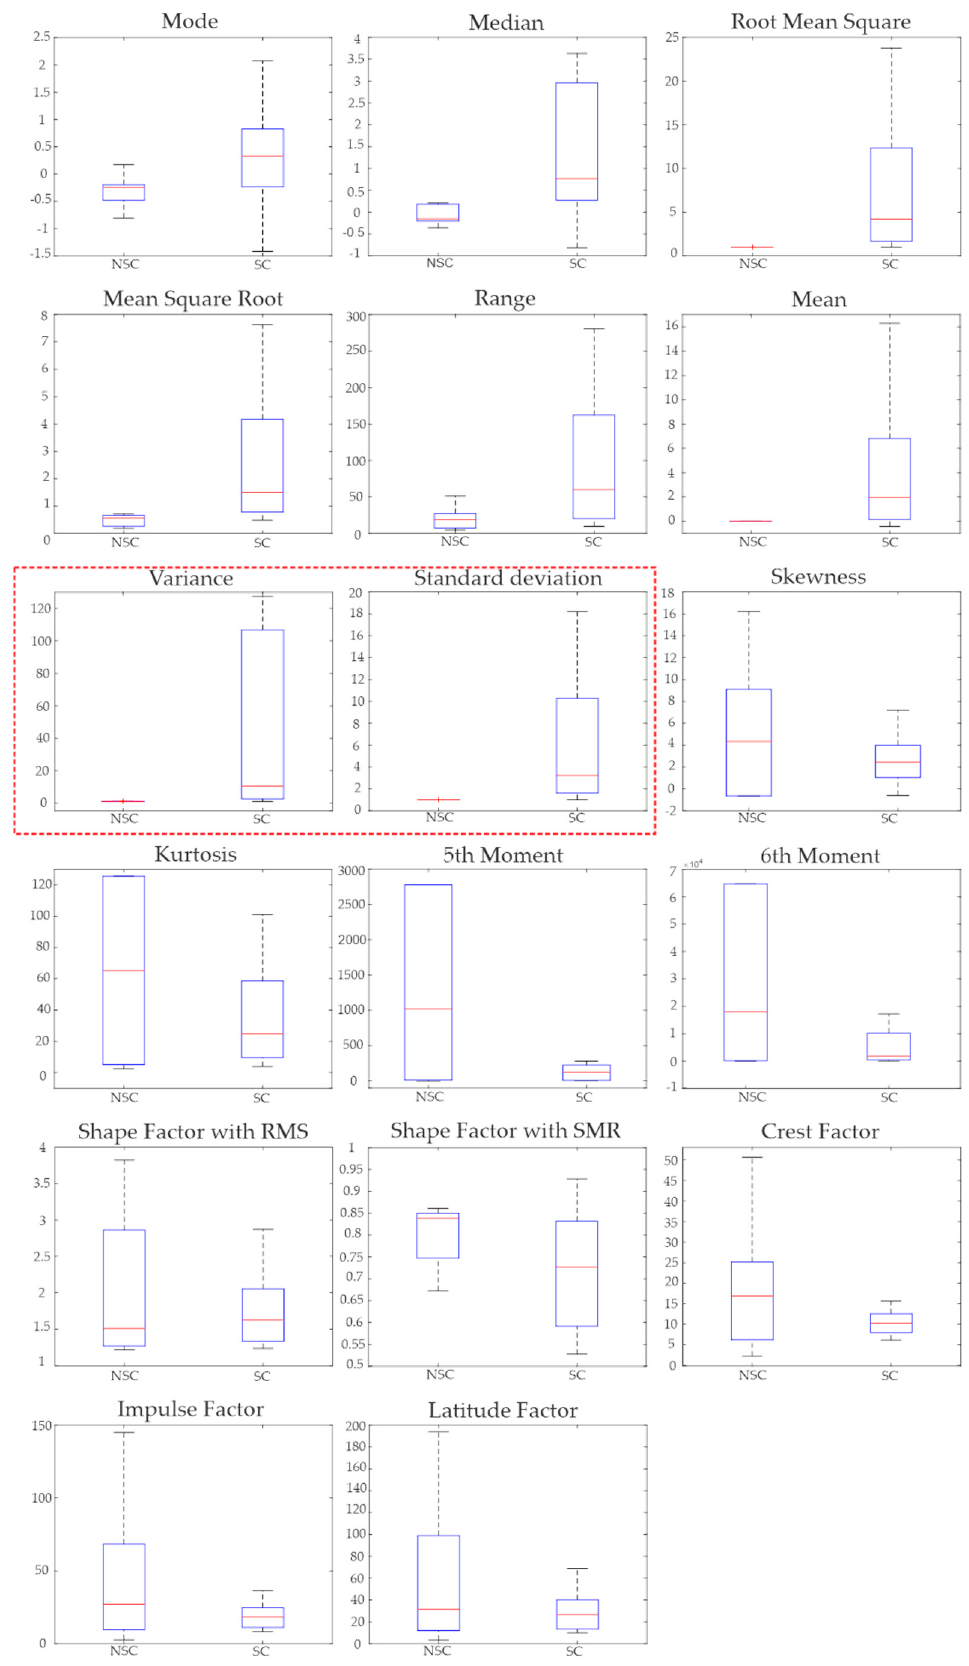
Figure 8. Box diagrams of the 17 STFs of no stress condition (NSC) and stress condition (SC).